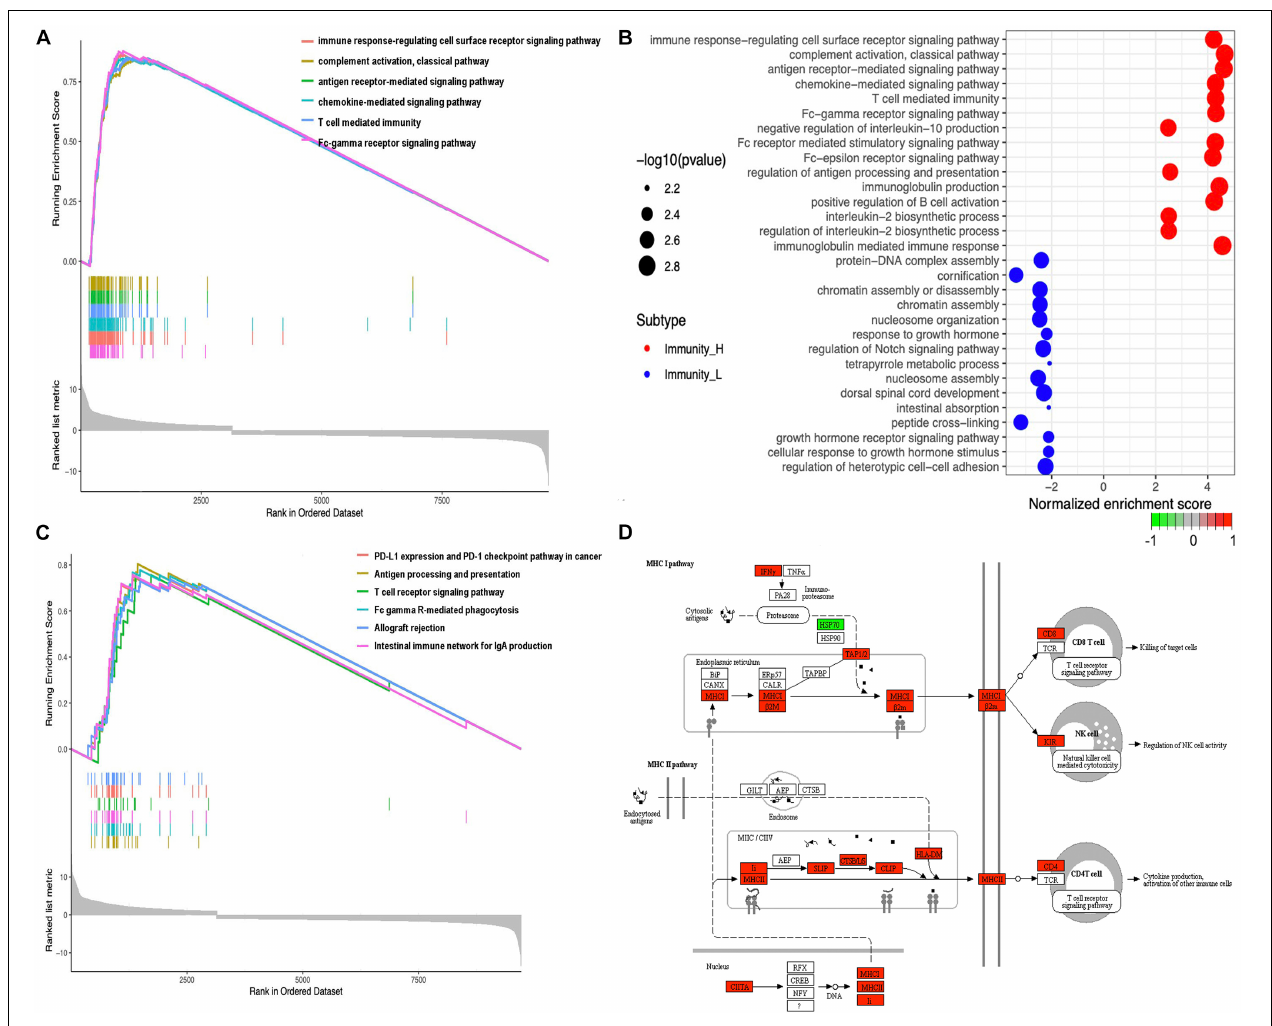
FIGURE 4 | Functional and pathway enrichment analyses. (A) The GO enrichment analysis in different expressed genes between the high- and low-abundance immune groups. Only gene sets with NOM p < 0.05 and FDR q < 0.05 (adjusted p -value using the Benjamini-Hochberg procedure to control the FDR) were considered significant. Only six leading gene sets were displayed in the plot. (B) The up- and downregulated GO pathways among immune subtypes by running a gene set enrichment analysis (GSEA) in different expressed genes. Enrichment P -values were based on 10,000 permutations and subsequently adjusted for multiple testing using the Benjamini-Hochberg procedure to control the FDR. (C) The KEGG enrichment analysis in different expressed genes between the high- and low-abundance immune groups. Only gene sets with NOM p < 0.05 and FDR q < 0.05 (adjusted p -value using the Benjamini-Hochberg procedure to control the FDR) were considered significant. Only six leading gene sets were displayed in the plot. (D) MHC-I pathway as an example for enriched